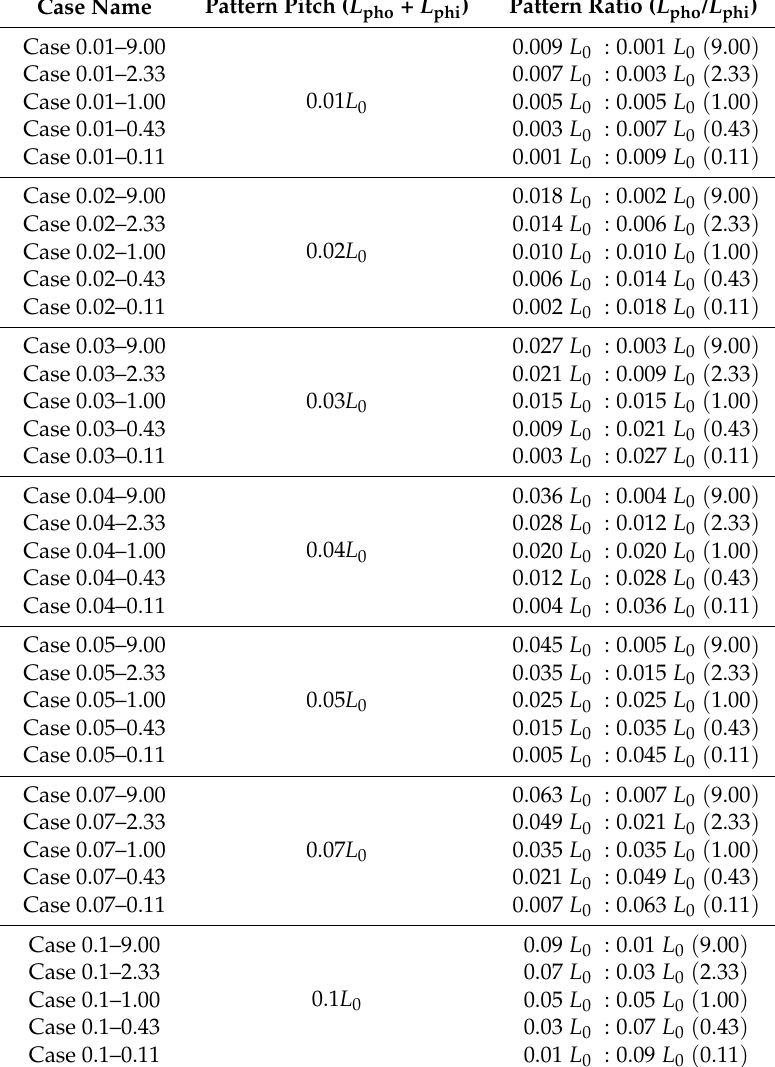
Table 1. Patterned wettability